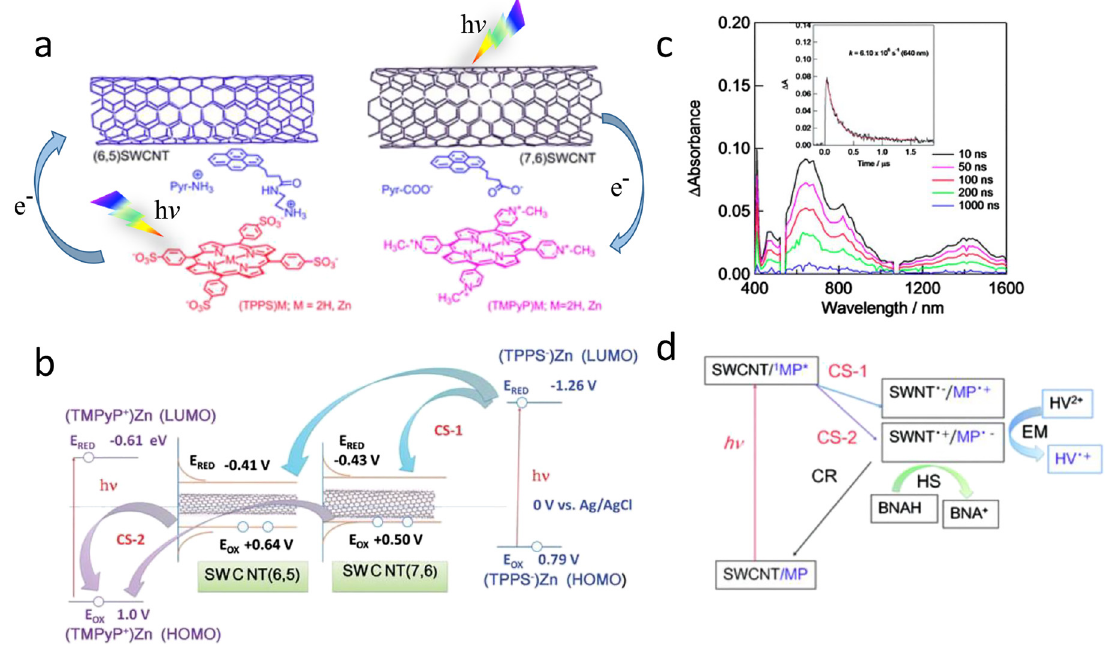
Figure 1: (a) Schematic diagram of photoinduced electron transfer of the (TPPS − )Zn/PyrNH 3 + /SWCNT(7, 6) hybrid, (b) Energy level diagram of MP (M = Zn and H 2 )/Pyr/SWCNT( n , m ) in polar media, (c) ns-TA of (TPPS − )Zn/PyrNH 3 + /SWCNT(7, 6) observed by 532-nm laser irradiation in Ar-saturated Dimethylformamide (DMF). Inset: absorption – time pro fi le at 640 nm, and red curve is the fi rst-order fi tting of this data, (d) Mechanism for the electron-pooling process [17]. ns-TA, nanosecond transient absorption; SWCNT, single-wall carbon